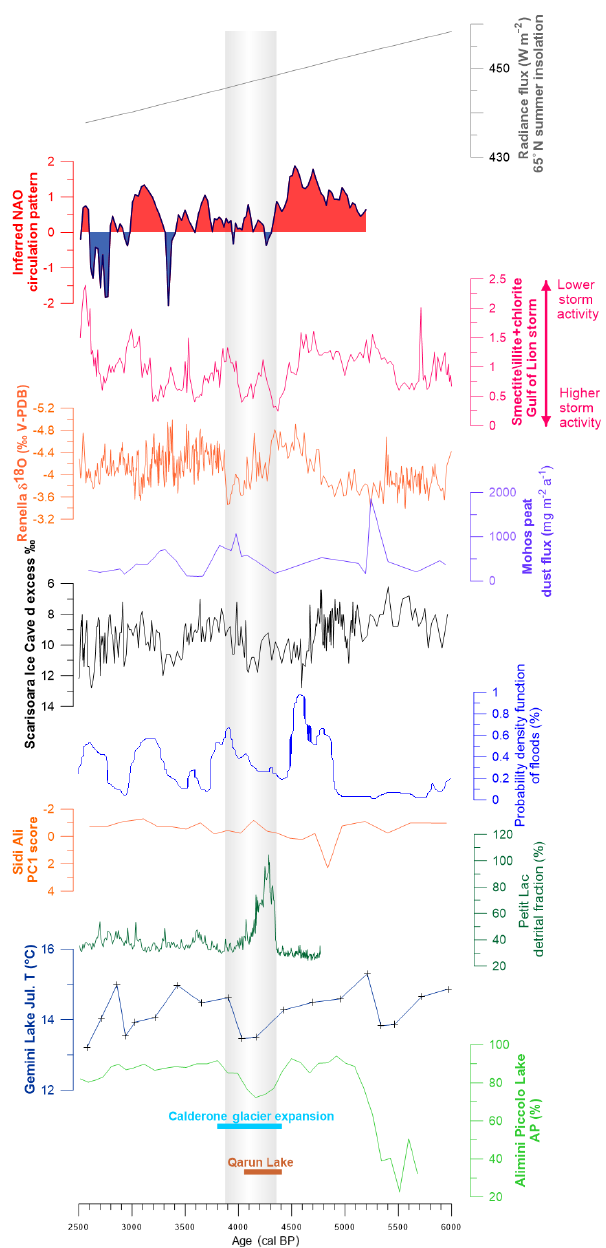
Figure 9. Selected additional records to illustrate the general sit- uation over the basin during the 4.2kaBP Event. Summer insola- tion curve at 65 ◦ N (Berger and Loutre, 1991); NAO index (Olsen et al., 2011); storm activity in the Gulf of Lion (Sabatier et al., 2012); Renella Cave (Zanchetta et al., 2016); Mohos peat dust flux (Longman et al., 2017); Sc ˘ ari¸soara Ice Cave, d excess in the ice cave (Per¸soiu et al., 2017); probability flood frequency from north Tunisia (Zielhofer and Faust, 2008); Sidi Ali dust flux (Ziel- hofer et al., 2017b); clastic input at Petit Lac (Brisset et al., 2013); Gemini Lake July temperature (Northern Apennines) (Samartin et al., 2017); Alìmini Pìccolo arboreal pollen (AP%) record (Di Rita and Magri, 2009); Calderone glacier expansion (Zanchetta et al., 2012a); Qarun Lake (Marks et al., 2018).